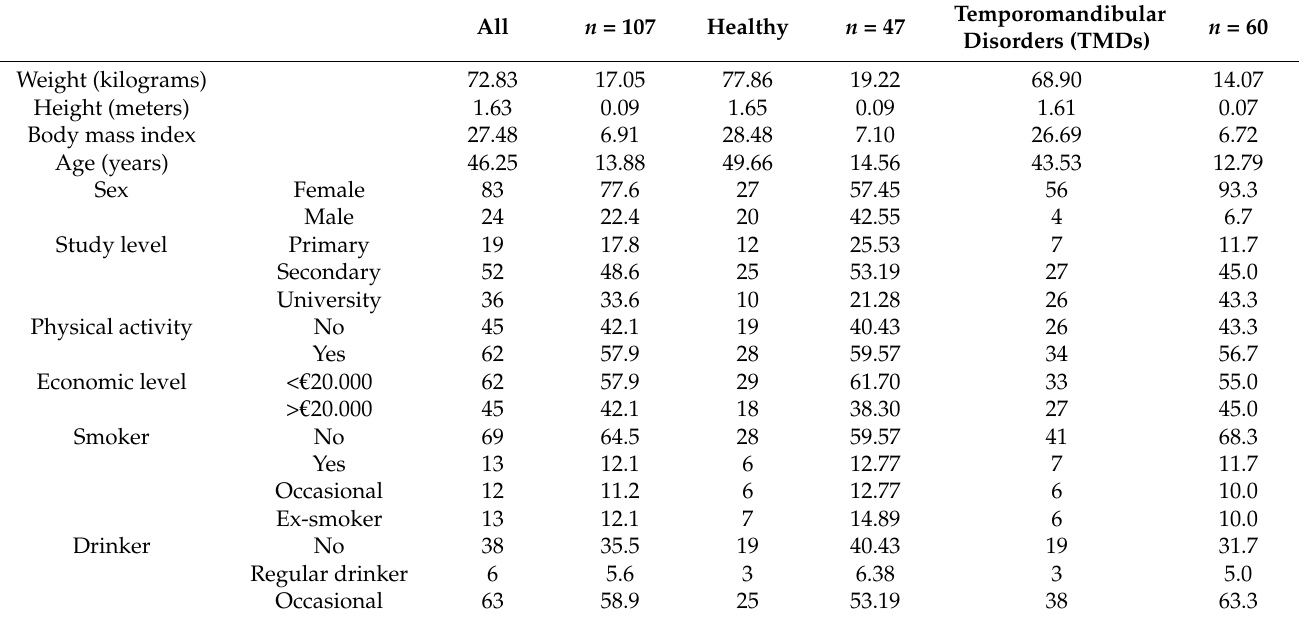
Table 1. Anthropometric and sociodemographic characteristics of the sample and groups.